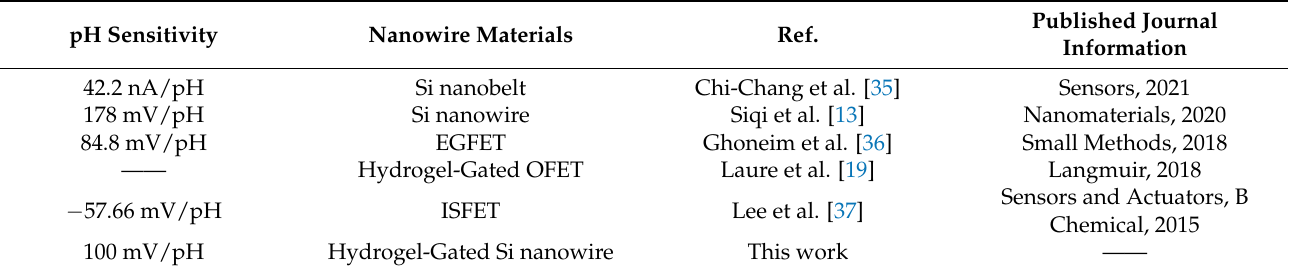
Table 1. Comparison of FET pH